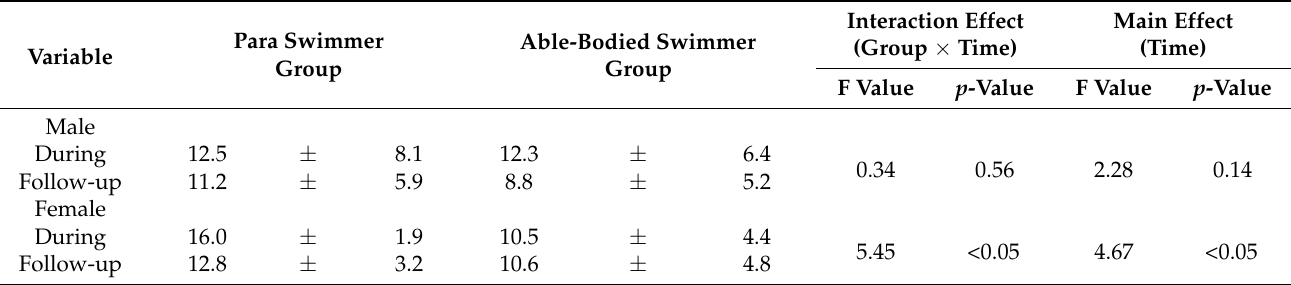
Table 2. Changes in the JAS of male and female swimmers during and follow-up post the lifting of the emergency. Interaction Effect Main Effect Para Swimmer Able-Bodied Swimmer (Group × Time) (Time) Variable Group Group F Value p -Value F Value p -Value Male During Female